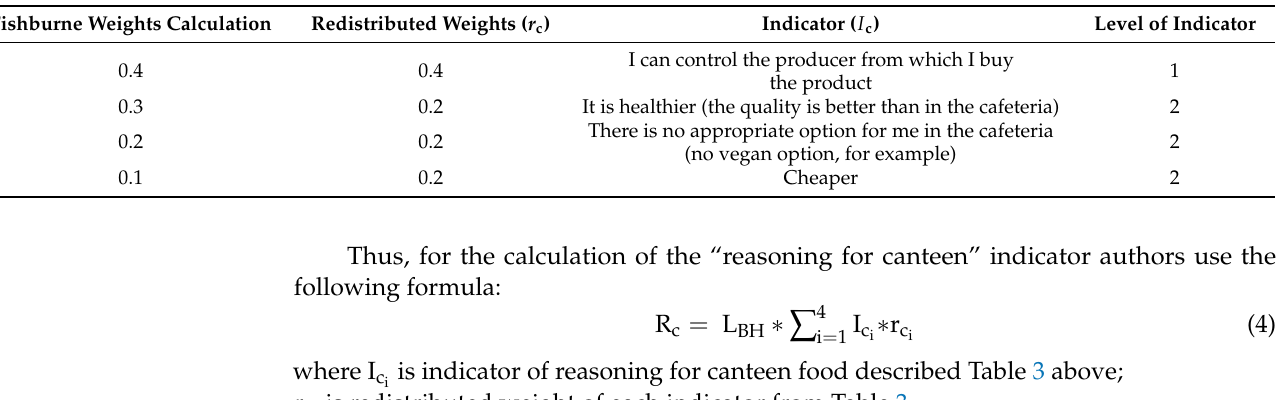
Table 3. Reasoning indicators for canteen option.